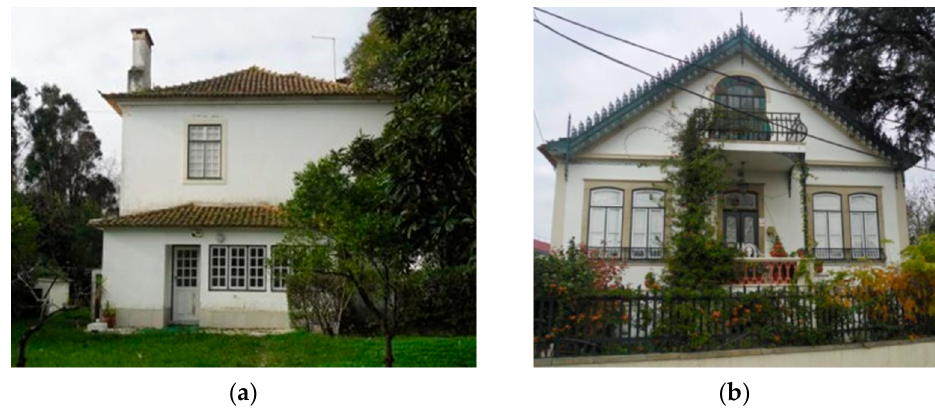
Figure 2. Photographs of the main façades: ( a ) two-story (Building 2); ( b ) 2-story plus an attic (Building 3). (Building